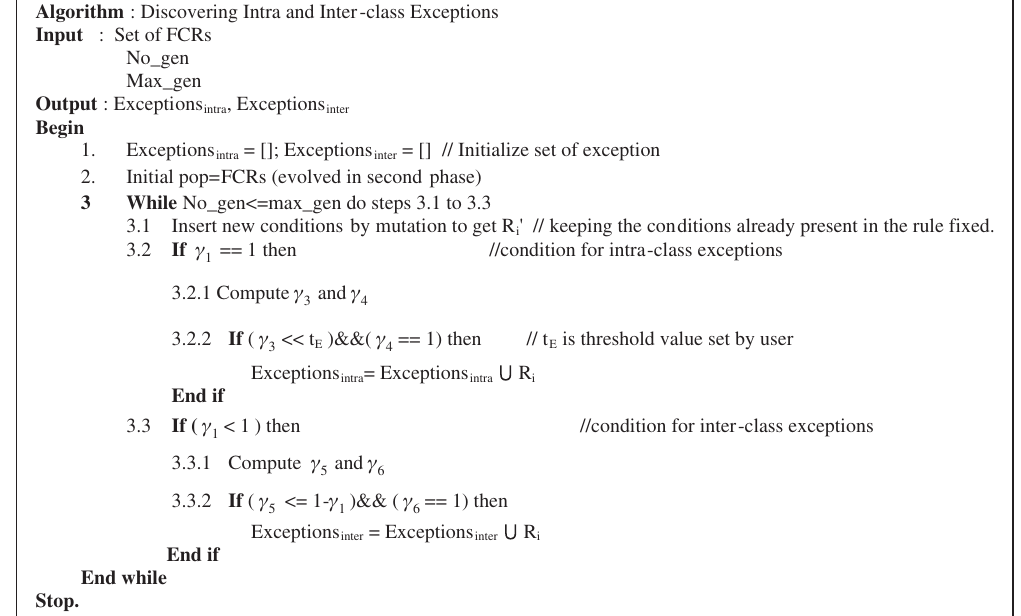
Figure 7: Algorithm to Discover Intra- and Inter-Class Exceptions in the Second